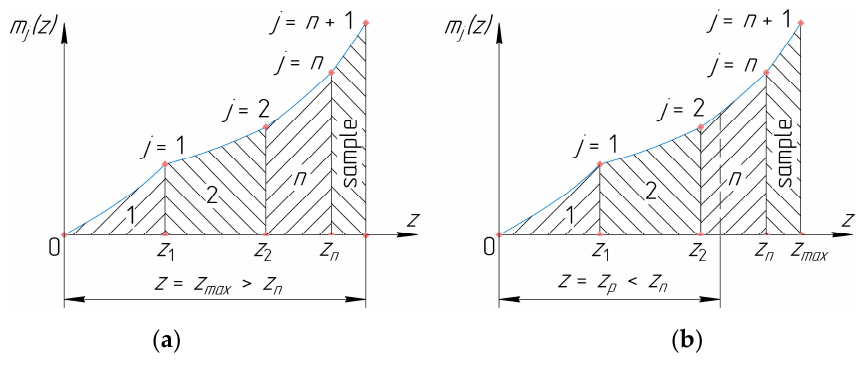
Figure 2. Mass loss distribution for the cases of z max > Δ s ( a ), and z max < Δ s ( b ).